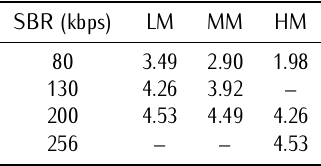
Table 3. Subjective tests results for QVGA.